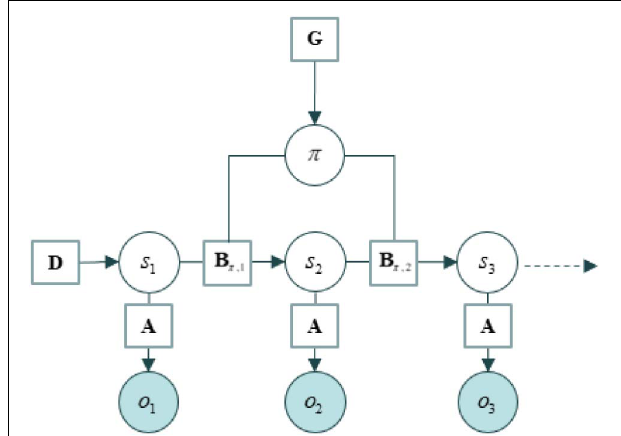
FIGURE 1 | A simple generative model for policy selection. This schematic depicts a generative model for policy selection. It represents probabilistic beliefs about how observations are related to the states that cause them (the likelihood matrix, which is denoted A), beliefs about the manner in which states of the world evolve over time (the state transition matrix, denoted B), and beliefs about states prior to sampling the world (prior beliefs, denoted D). Preferences over outcomes (C) are not depicted. From Friston et al. (2017b). For ease of visualization, we do not present the hierarchical structure of the generative process. The reader should assume that there structure of the generative process will include multiple levels. The important aspect of this schematic is to present the manner in which the generative model and the generative process interact with one another. The only reason we present multiple levels of the generative model is that two levels allows for a description of all the inner components of the script. Only one level of the generative process is needed to describe the external component (even though we should assume multiple levels of the generative process). The higher levels of a model constrain possible inference at the lower levels by unfolding over slower timescales and by setting the prior beliefs about initial states D at the lower level–that contextualize the ensuing state transitions or narratives. In such models, posterior estimates of successive states at the lower level become data or observations for inference at the level